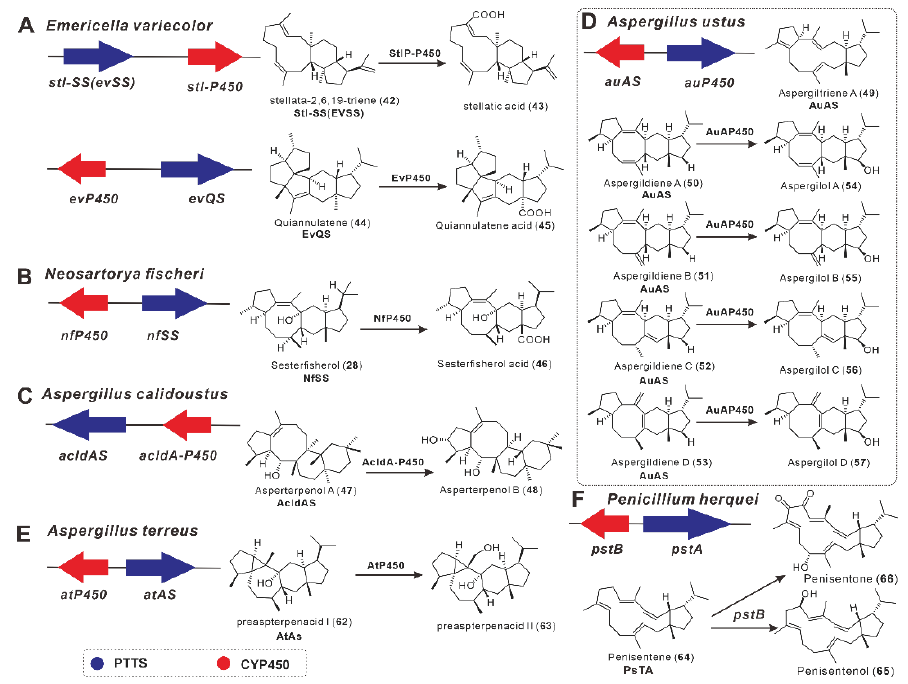
Figure 6. The BGCs composed of PTTSs and CYP450s and their biosynthesis. ( A – F ) represent six fungal sources of BGCs composed of PTTSs and CYP450s.Okada et al. discovered another PTTS, EvQS, from E. variecolor through genome mining in 2016, and expressed it in A. oryzae to produce quannulatene ( 44 ). Compound 44 was then oxidized to quannulati acid ( 45 ) by CYP450 enzymes located near the EvQS gene (Figure 6A). Feeding experiments with isotopically labeled acetates and in vitro experiments with GFPP isotopoisomer revealed that 44 cyclizes in an unprecedented manner to form a unique fused 5-6-5-5-5 ring [39].